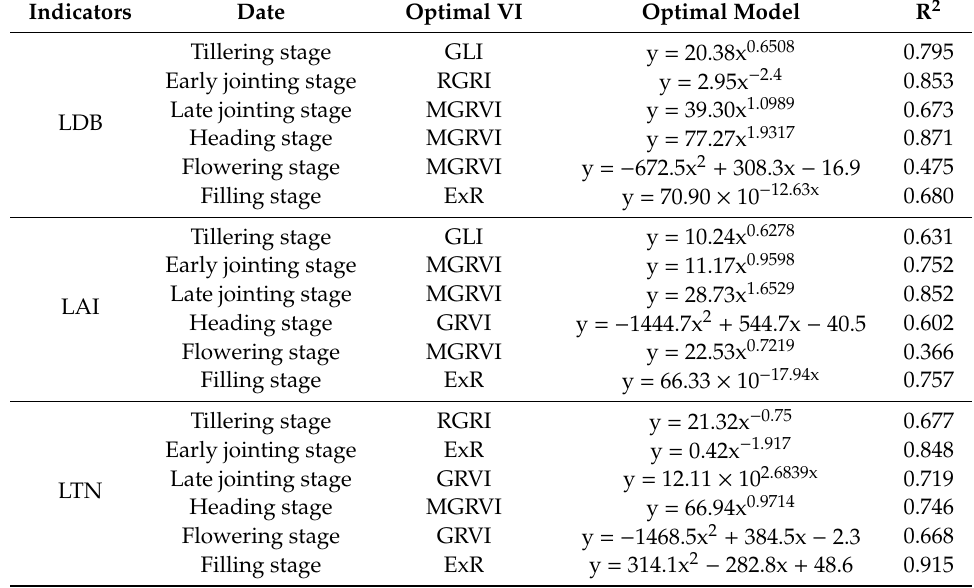
Table 5. Optimized model between the key growth indicators and UAV-VI at di ff erent growth stages of